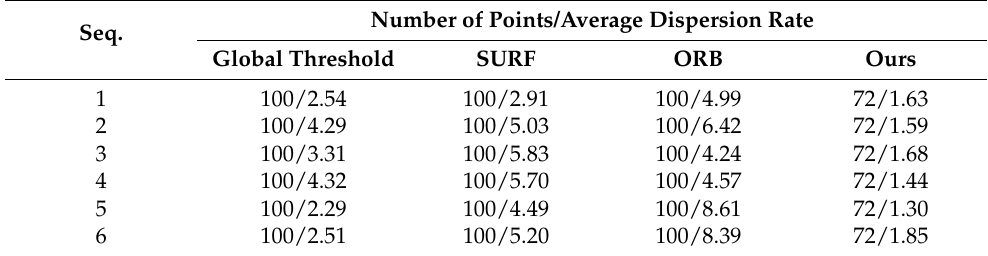
Table 3. Comparison of dispersion rates of selected stable stars among the proposed method and baselines. Seq.